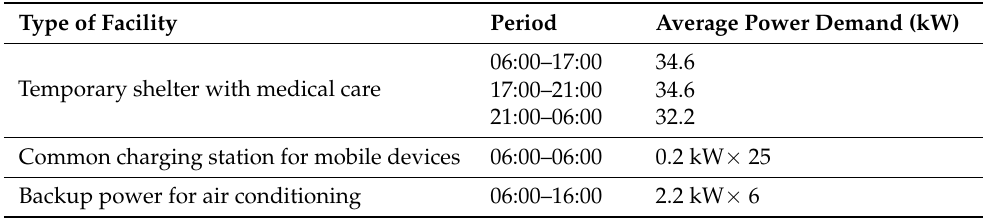
Table 3. Energy demand by time of day in resilience facilities supported by VIPV. Type of